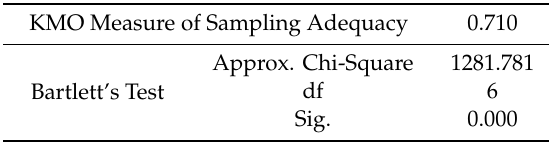
Table 4. Results of the Kaiser-Meyer-Olkin (KMO) measure and Bartlett’s sphericity test.